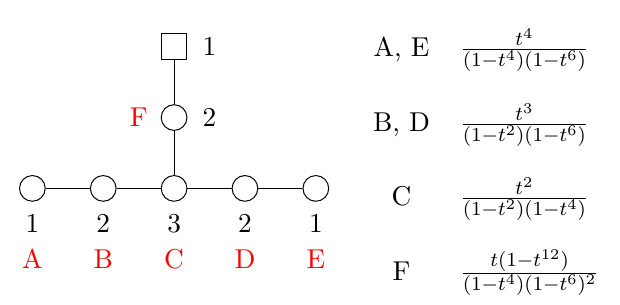
Table 17. E 6 family for k = 1 . B-twisted index with Wilson lines at the labelled position in the